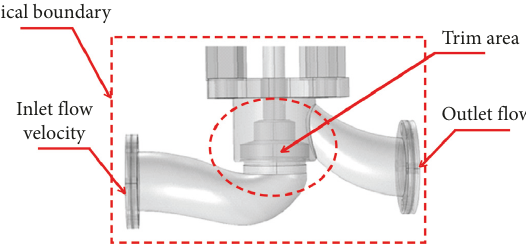
Figure 1: An internal view for the valve